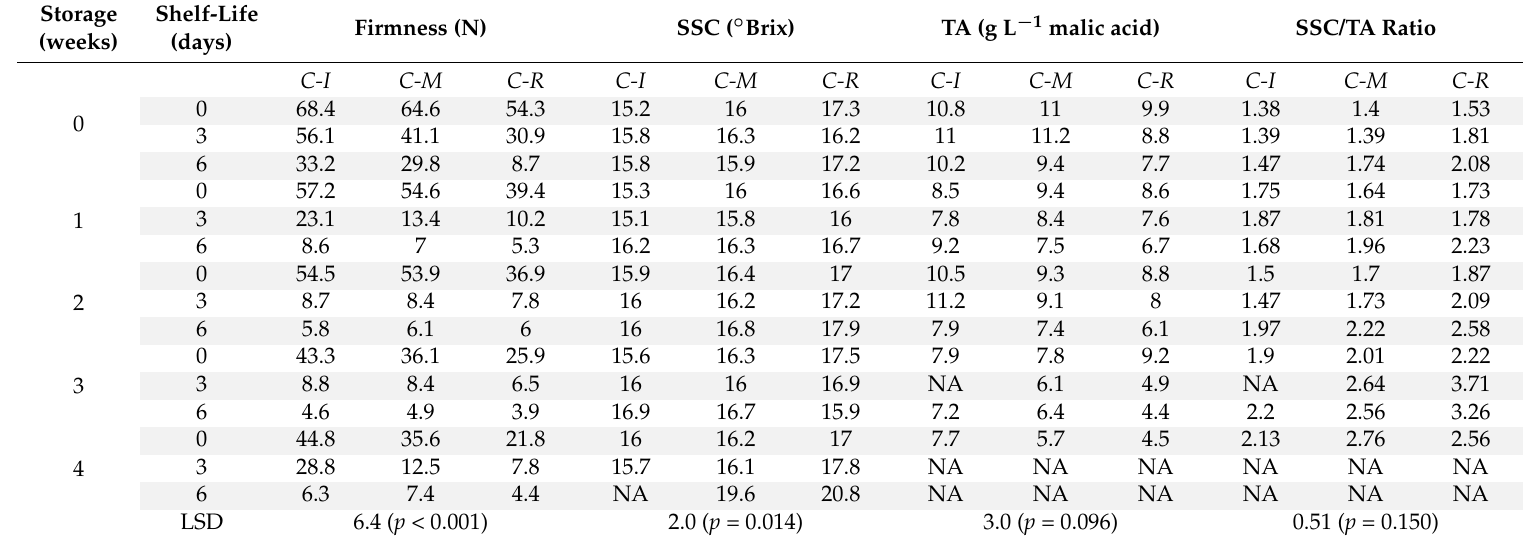
Table 2. Fruit quality evolution based on Firmenss (N), SSC ( ◦ Brix), TA (g L − 1 malic acid), and SSC/TA ratio assessment. ‘August Flame’ peaches were analysed at harvest (week 0) and after storage (0 ◦ C) for up to 4 weeks and shelf- life (ambient, 18 ◦ C) for up to 6 days for C-I (immature), C-M (mature) and C-R (ripen) fruit. LSD indicates significant differences for both maturity classes and days of